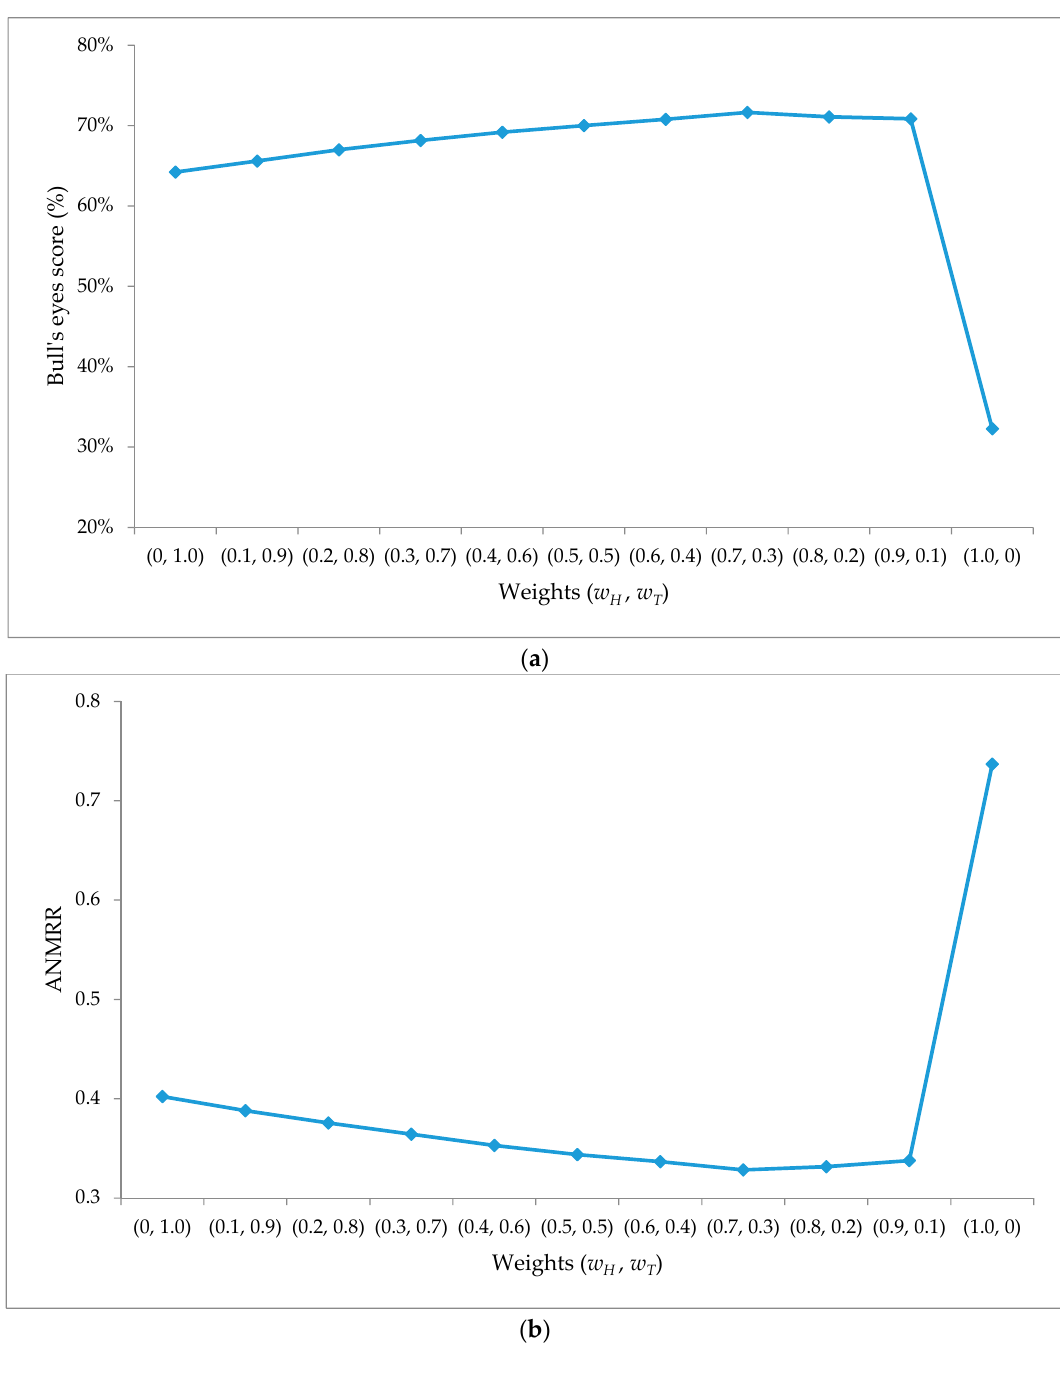
Figure 9. The analysis of the weighing combinations for parameters H w and T w using ( a ) the BES and ( b ) the average normalized modified retrieval rank ( ANMRR ) scores.